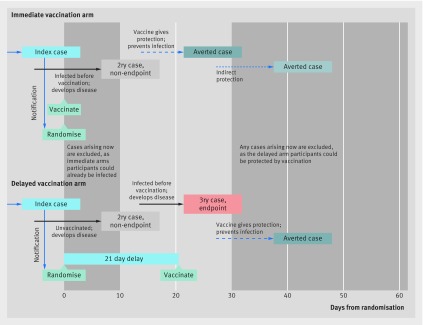
Fig 1 Development of cases arising in two hypothetical, simplified, example trial rings, which are identical but for receipt of immediate or delayed (by 21 days) vaccination. Case boxes indicate the presence of symptoms and infectiousness. Arrows indicate disease incubation periods after infection. Because disease onset is detected rather than the point of infection, the shaded areas show periods in which any cases arising would be excluded from an analysis of vaccine efficacy against infection. This example shows a window which assesses the vaccine’s ability to offer protection from the day of administration. Three cases arise during the trial; one contributes to the analysis